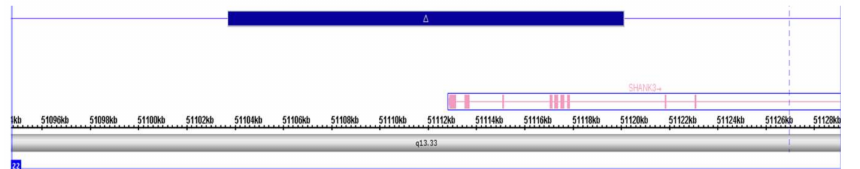
Figure 1. SNP array analysis demonstrating the duplication affecting the first seven exons of the SHANK3